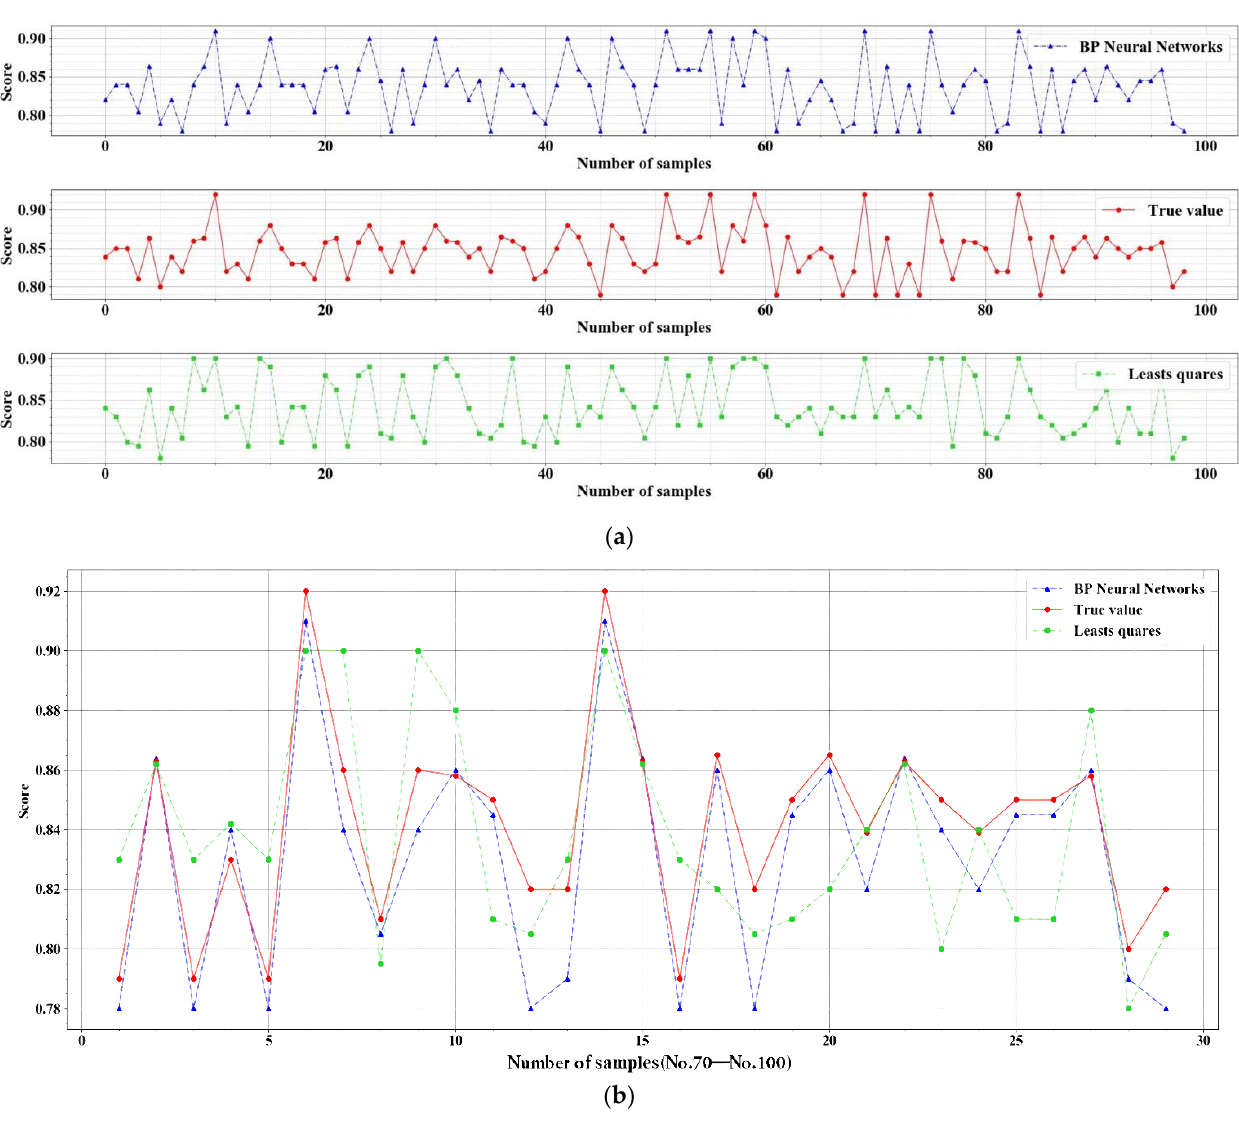
Figure 4. ( a ) shows the fitting result under each methods of a 100 samples cut; ( b ) shows the com- parison results of fit rates of a 30 samples